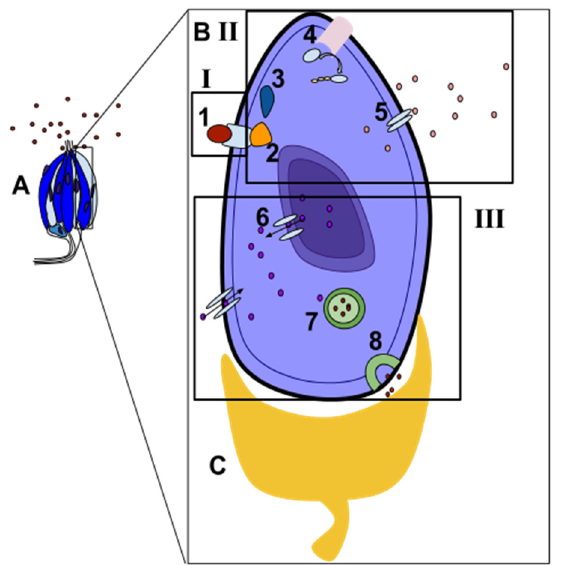
Figure 3. Diagram showing the signal transduction pathway of bitter taste. A , taste bud; B , taste cell; and C , neuron attached to B . Adapted from Hldavis4